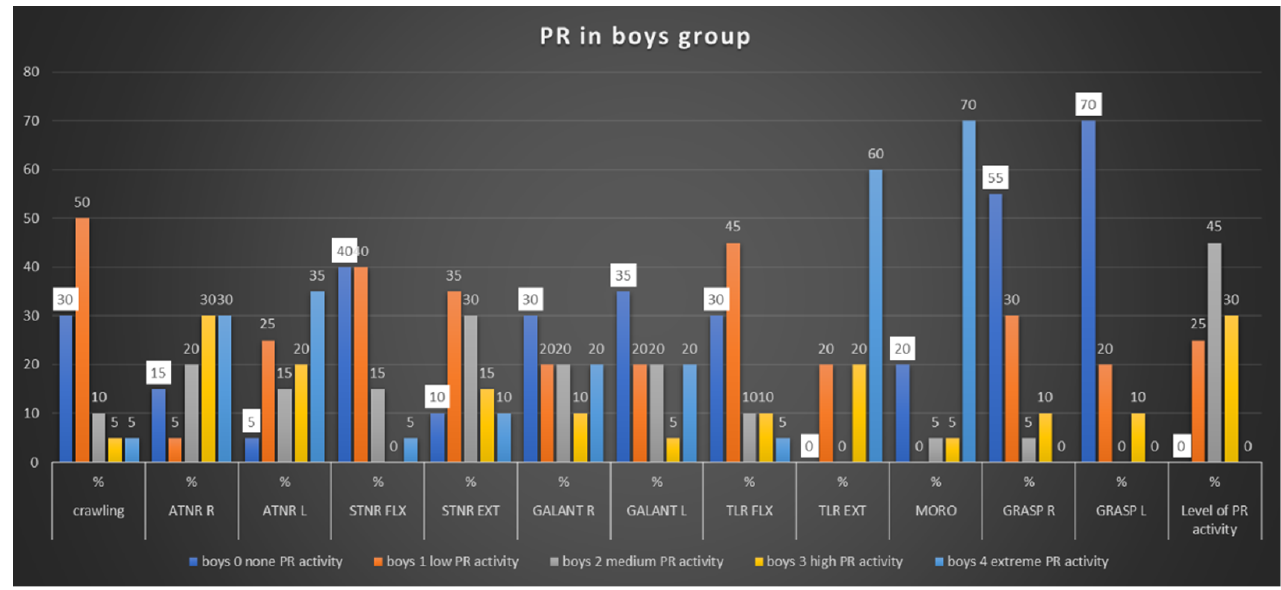
Figure 1. The scale of primitive reflexes (PRs) activity in boys. Percentage of crawling pattern performance and the reflexes activity.